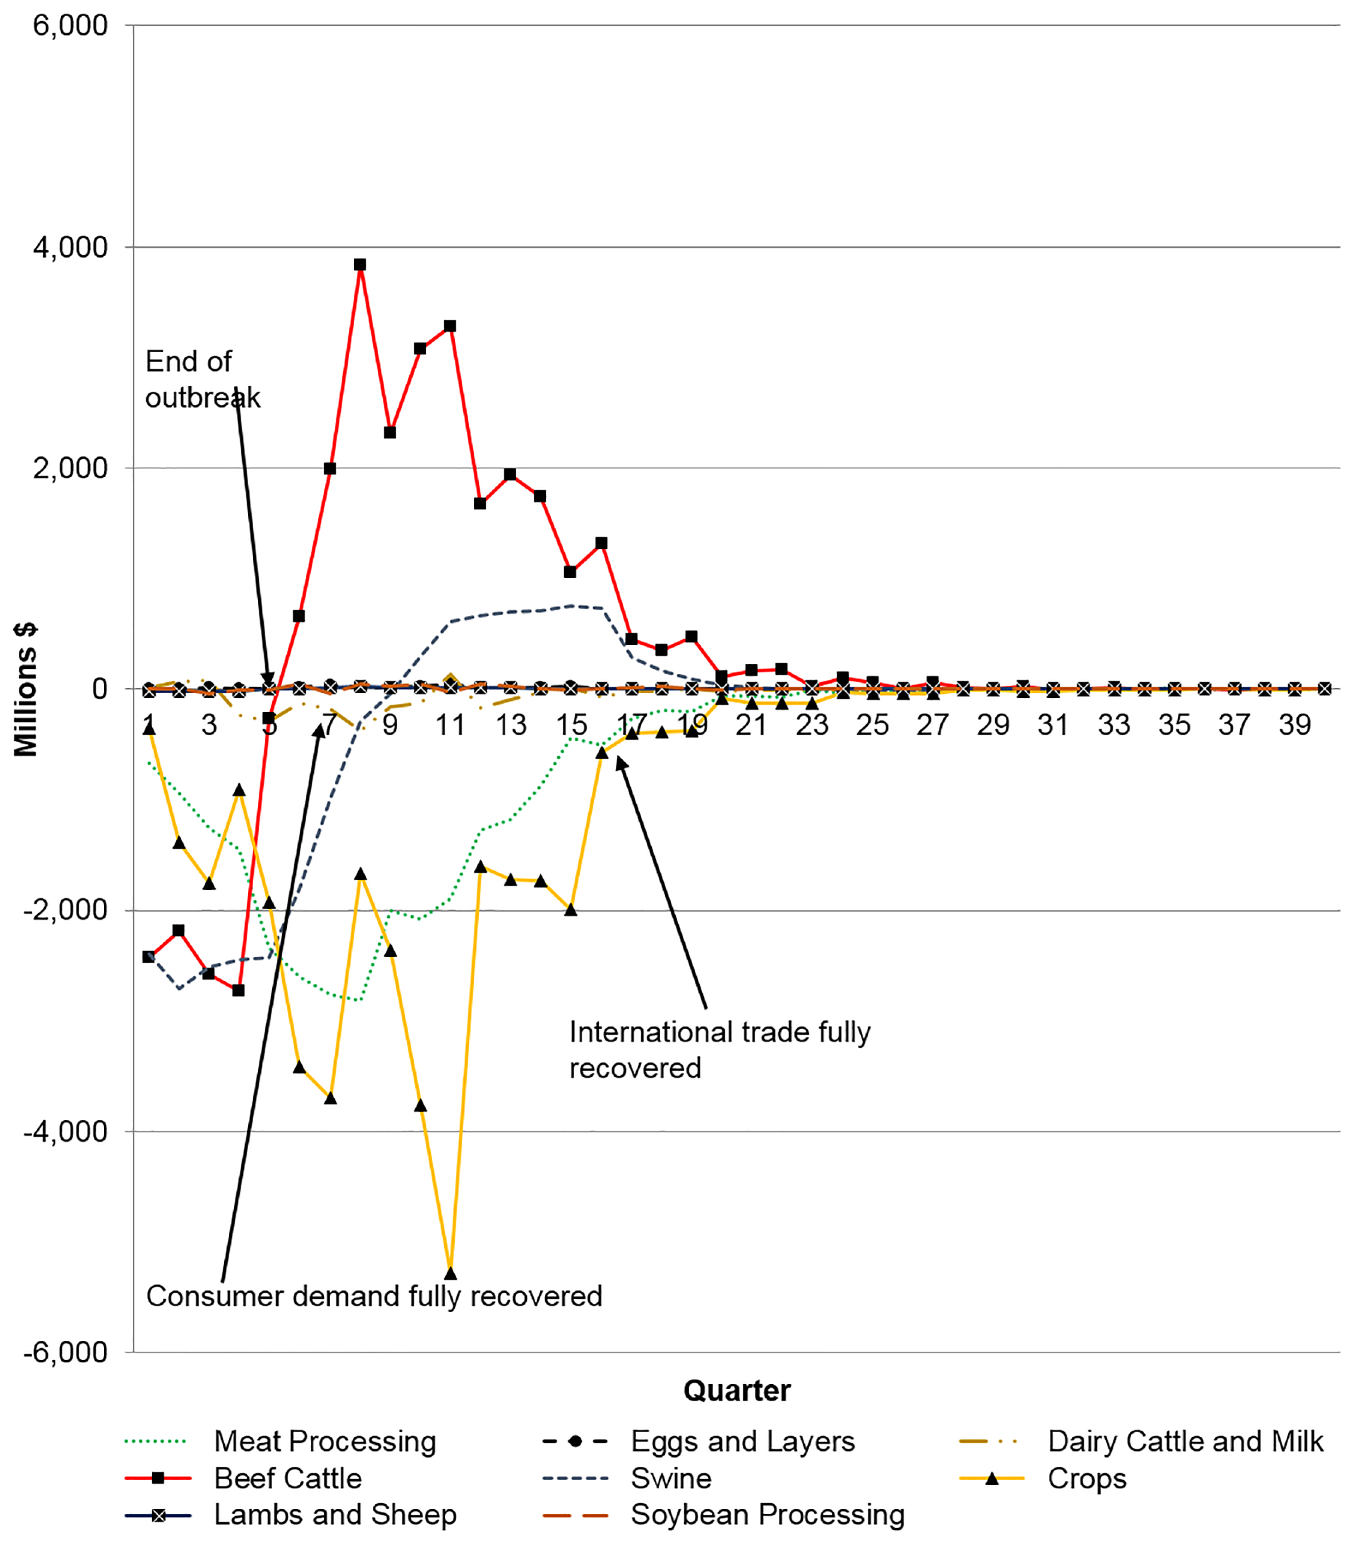
Fig 1. Changes in Producers Returns to Capital and Management for Liquid Waste Event, P50/P50 Scenario.